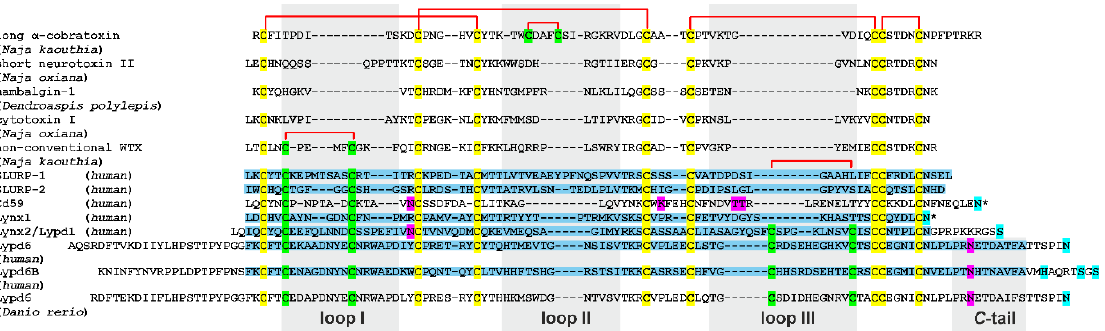
Figure 1. Amino acid sequence alignment of three-finger proteins (TFPs). Representative snake toxins from various families, several human TFPs, and fish Lypd6 are shown. The signal peptides are removed. Invariant Cys residues are shown in yellow. Cys residues forming additional disulfide bonds in the loops I, II, and III are shown in green. Disulfide bonds are shown by red brackets. Predicted sites for attachment of the GPI-anchor and glycosylation are shown by cyan and magenta, respectively. Several possible GPI-anchor sites were predicted for human Lypd6b. Fragments of the proteins used for NMR studies in this and previous works [11] are highlighted in blue. The proteins, for which the presence of both the GPI-anchored and soluble form were reported, are marked by an asterisk. The loop regions and C -terminal regions used for calculation of mean RMSD and S 2 values are highlighted by gray background. PDB codes: α -cobratoxin—2CTX, neurotoxin II—2MJ4,